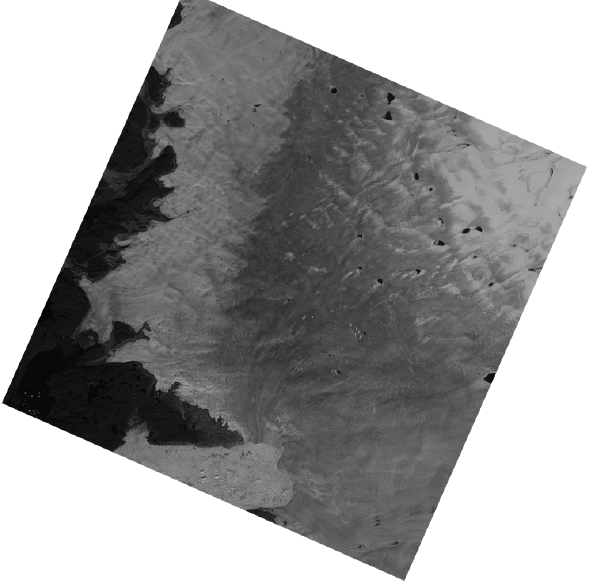
Fig. 9. ASTER image of 11 August 2008. The outlet glacier in the bottom of the image is Jakobshavn Isbrae.